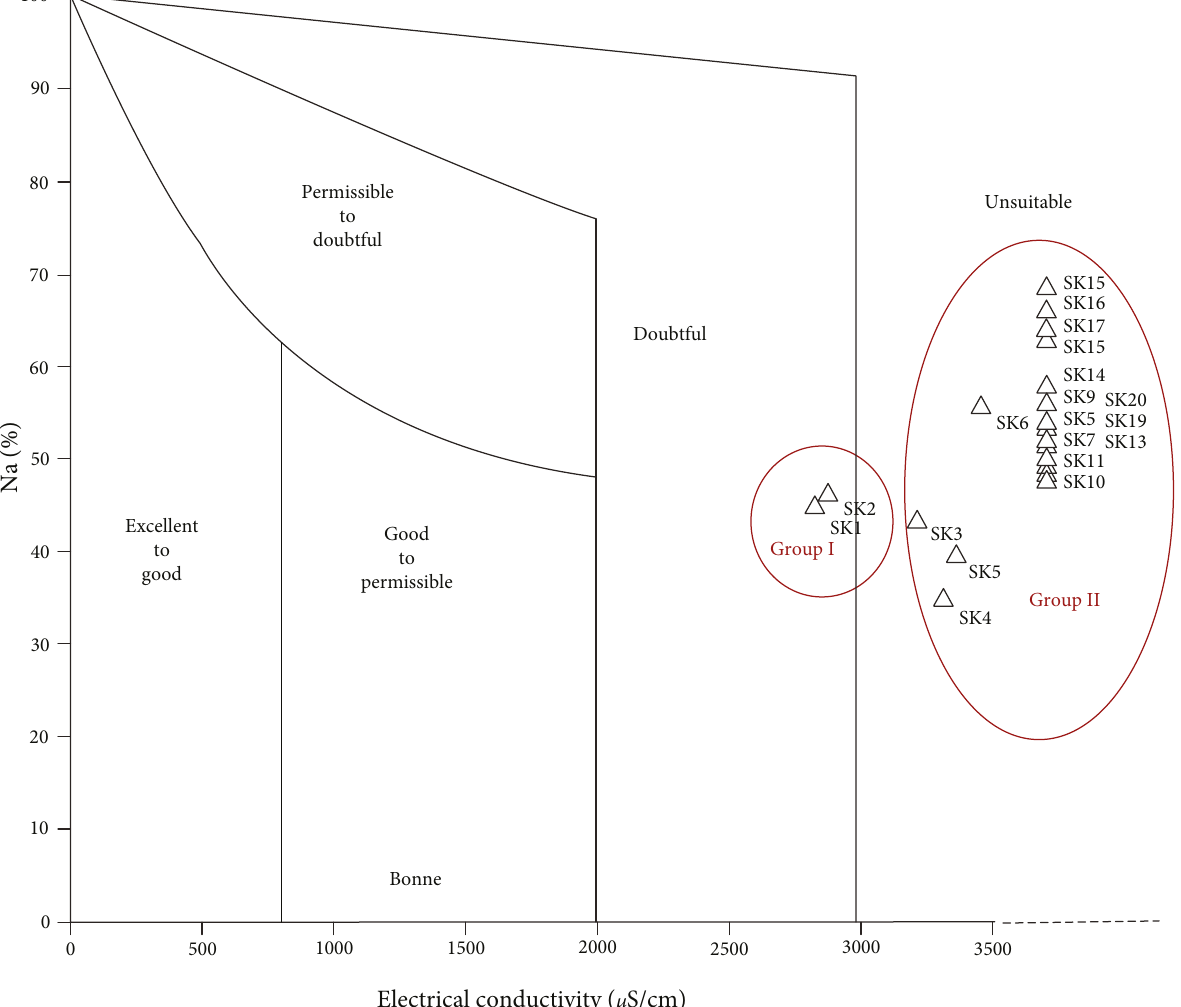
Figure 10: Wilcox diagram for the Skhira phreatic aquifer